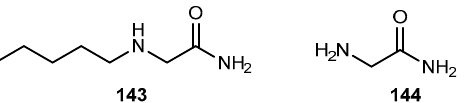
Figure 60. Chemical structures of melacemide ( 143 ) and glycinamide ( 144 ).